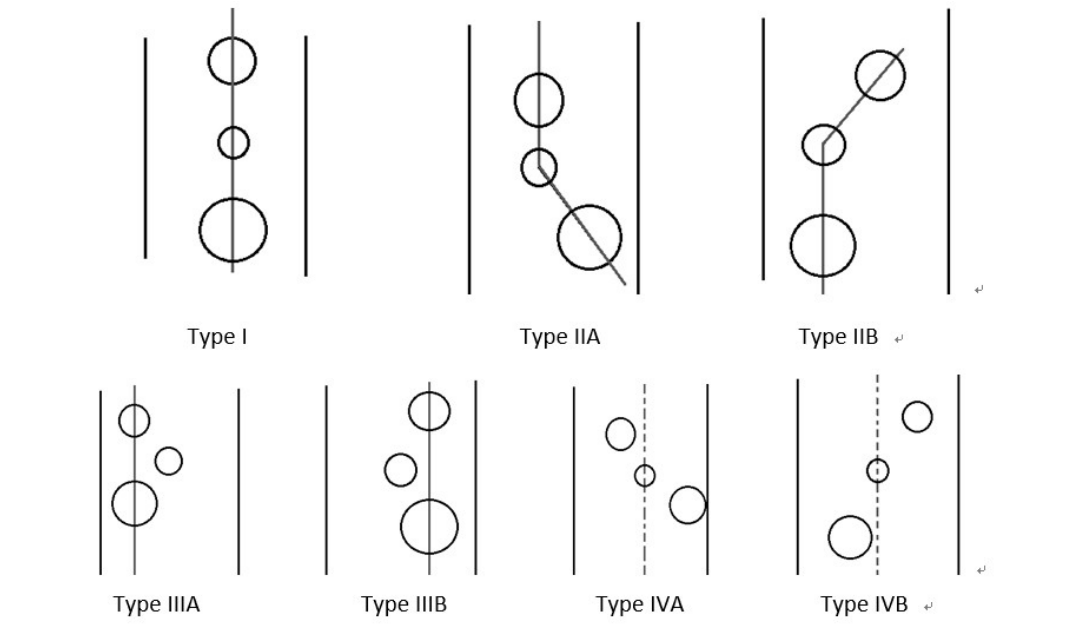
Fig. 4 - Three-branch opening